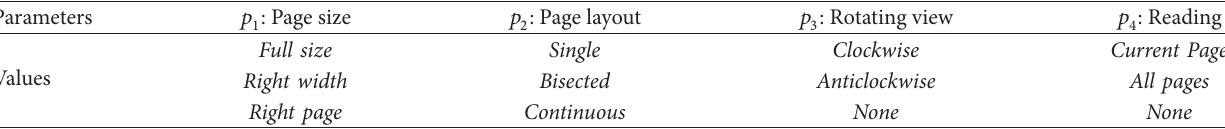
Table 1: Optional parameters and values of an option “View” in the tool